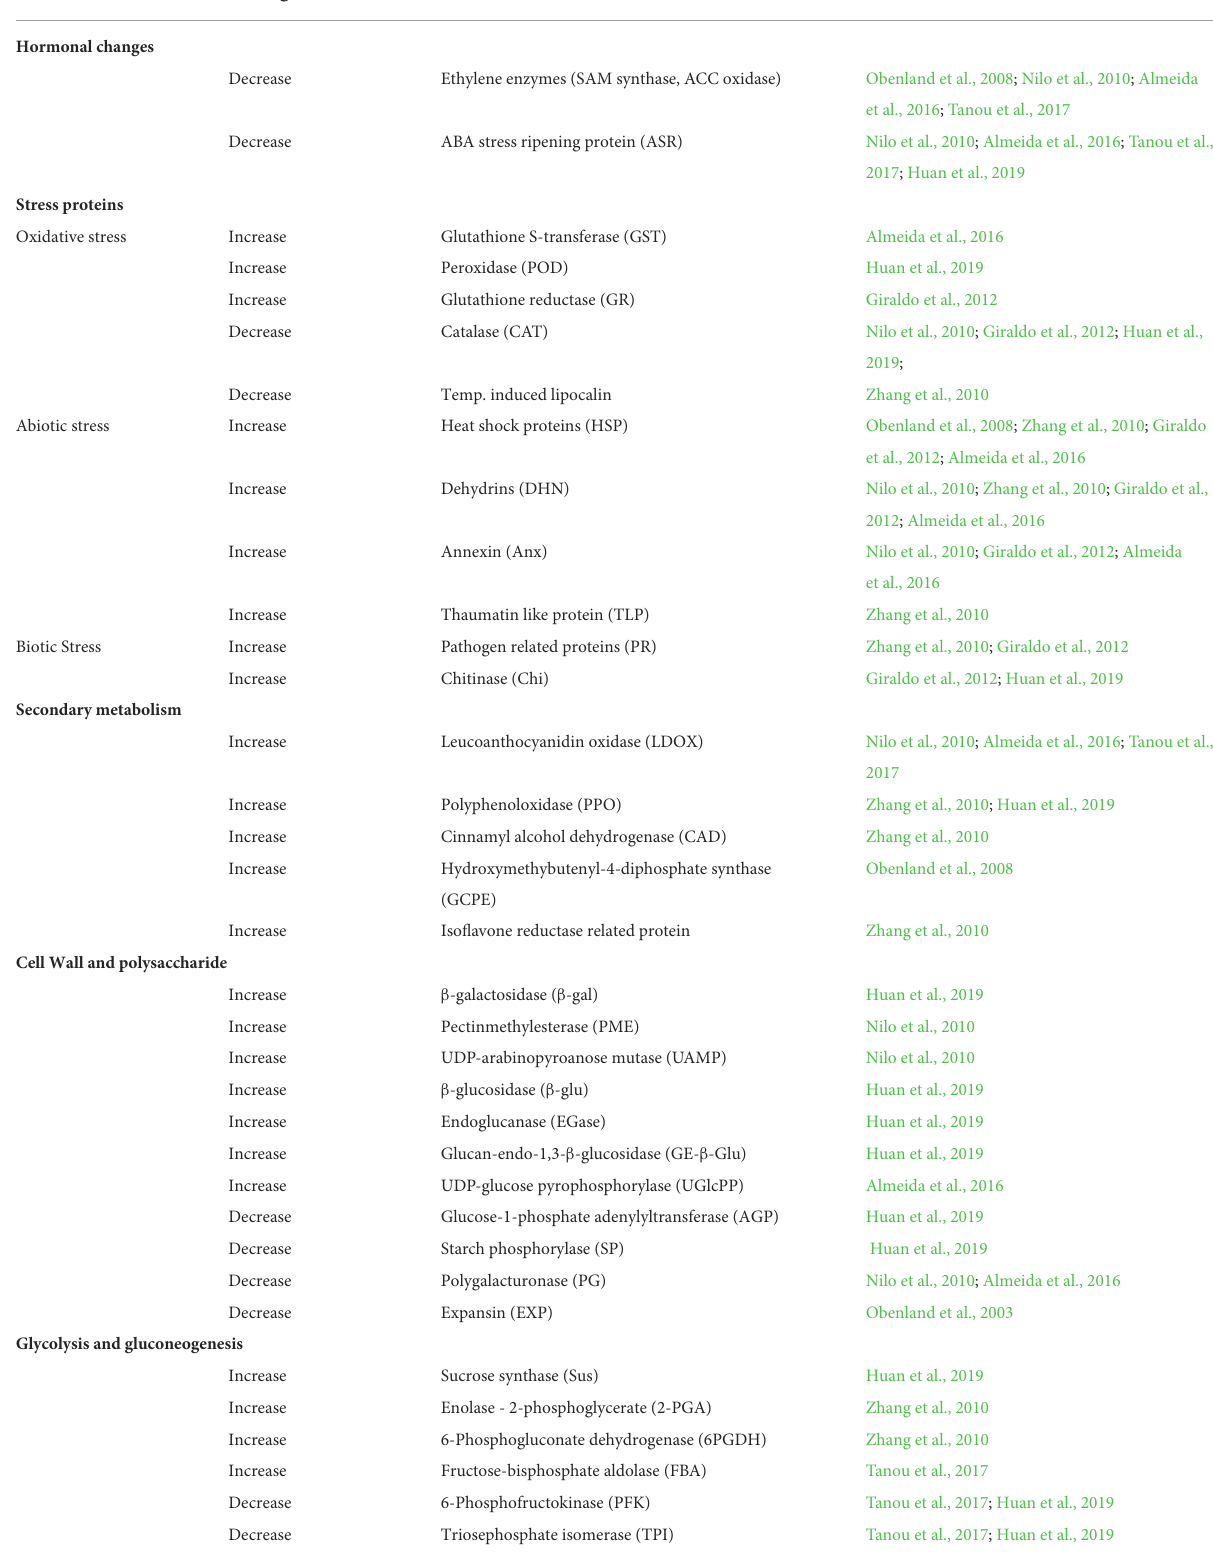
TABLE 2 Proteomic changes during chilling injury